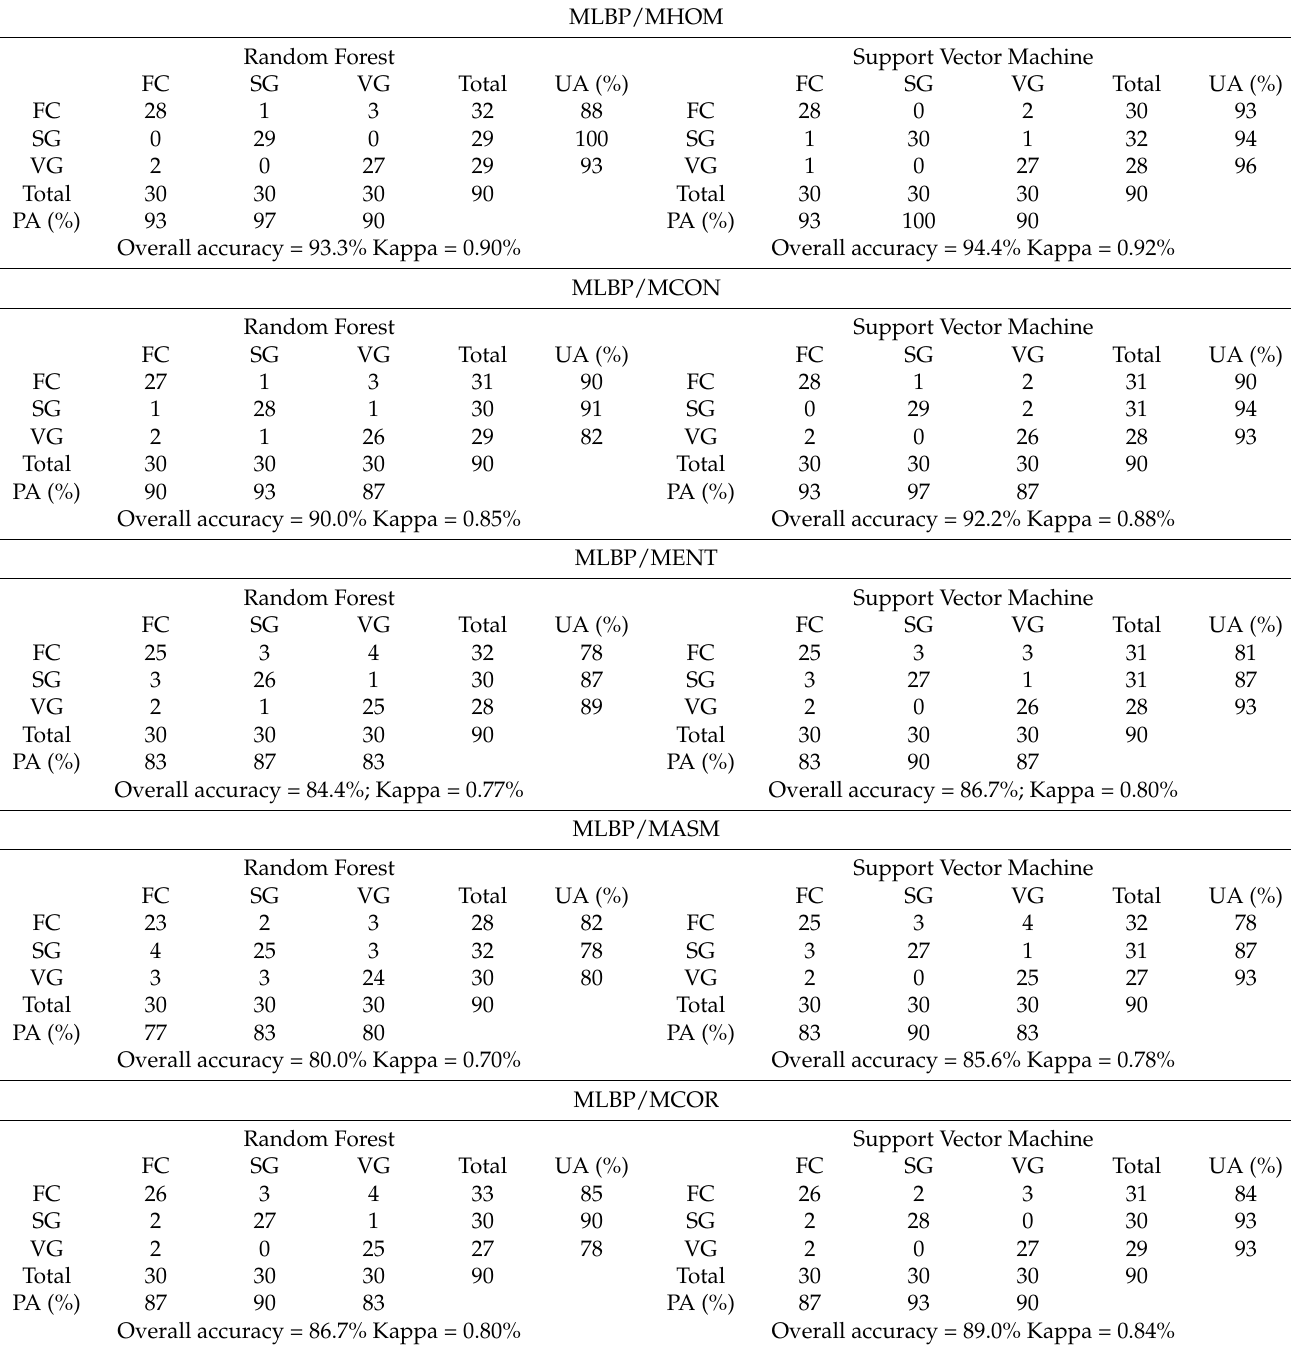
Table 4. Confusion matrices for random forest and support vector machine classifiers for the MLBP/MHOM, the MLBP/MCON, the MLBP/MENT, the MLBP/MASM, and the MLBP/MCOR models for image block D.